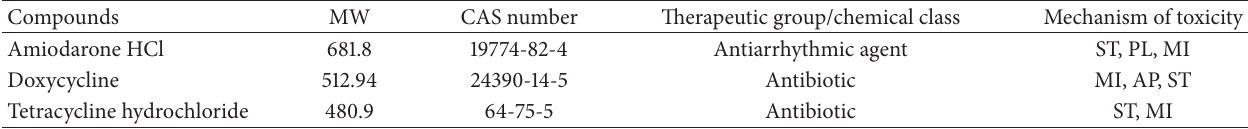
Table 1: Compounds studied according to their documented mechanism of action.